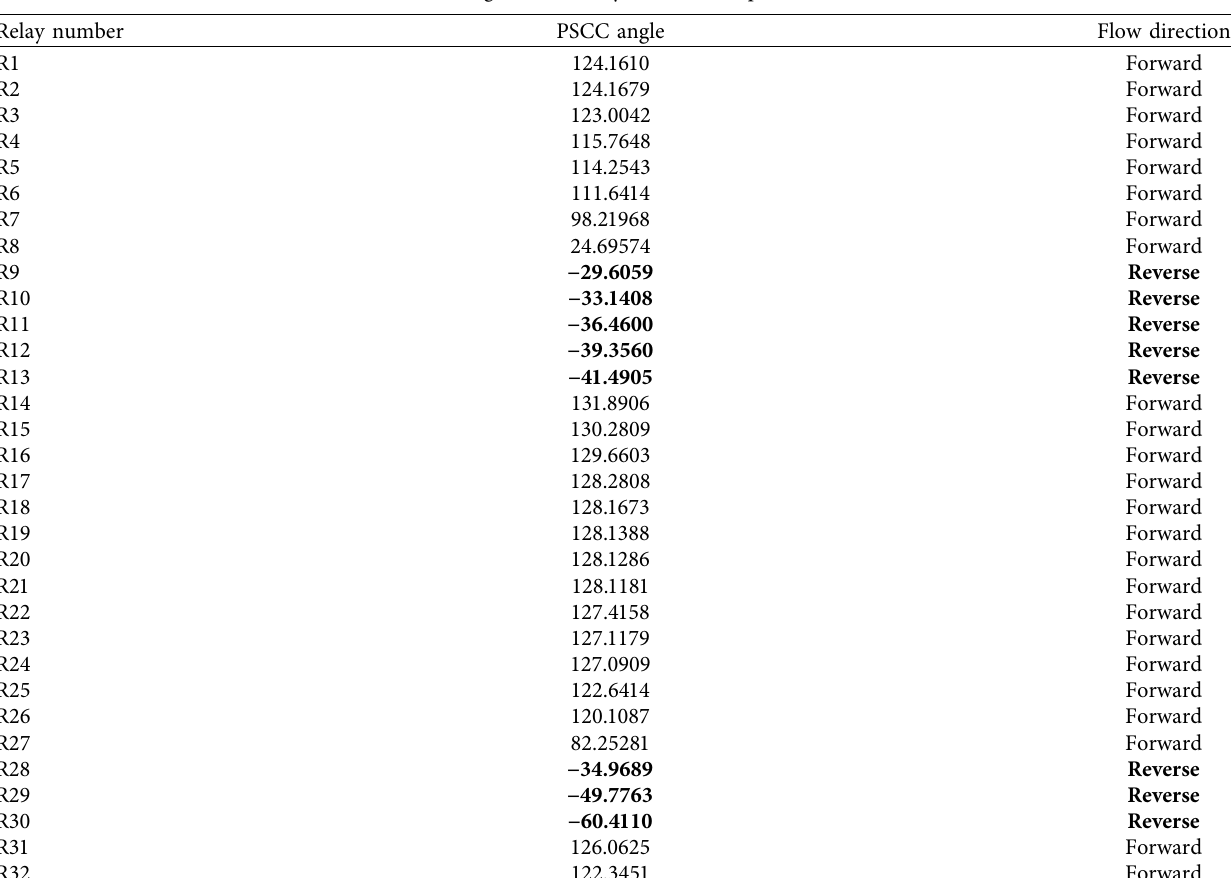
Table 4: PCSS angle for all relays at normal operation (case